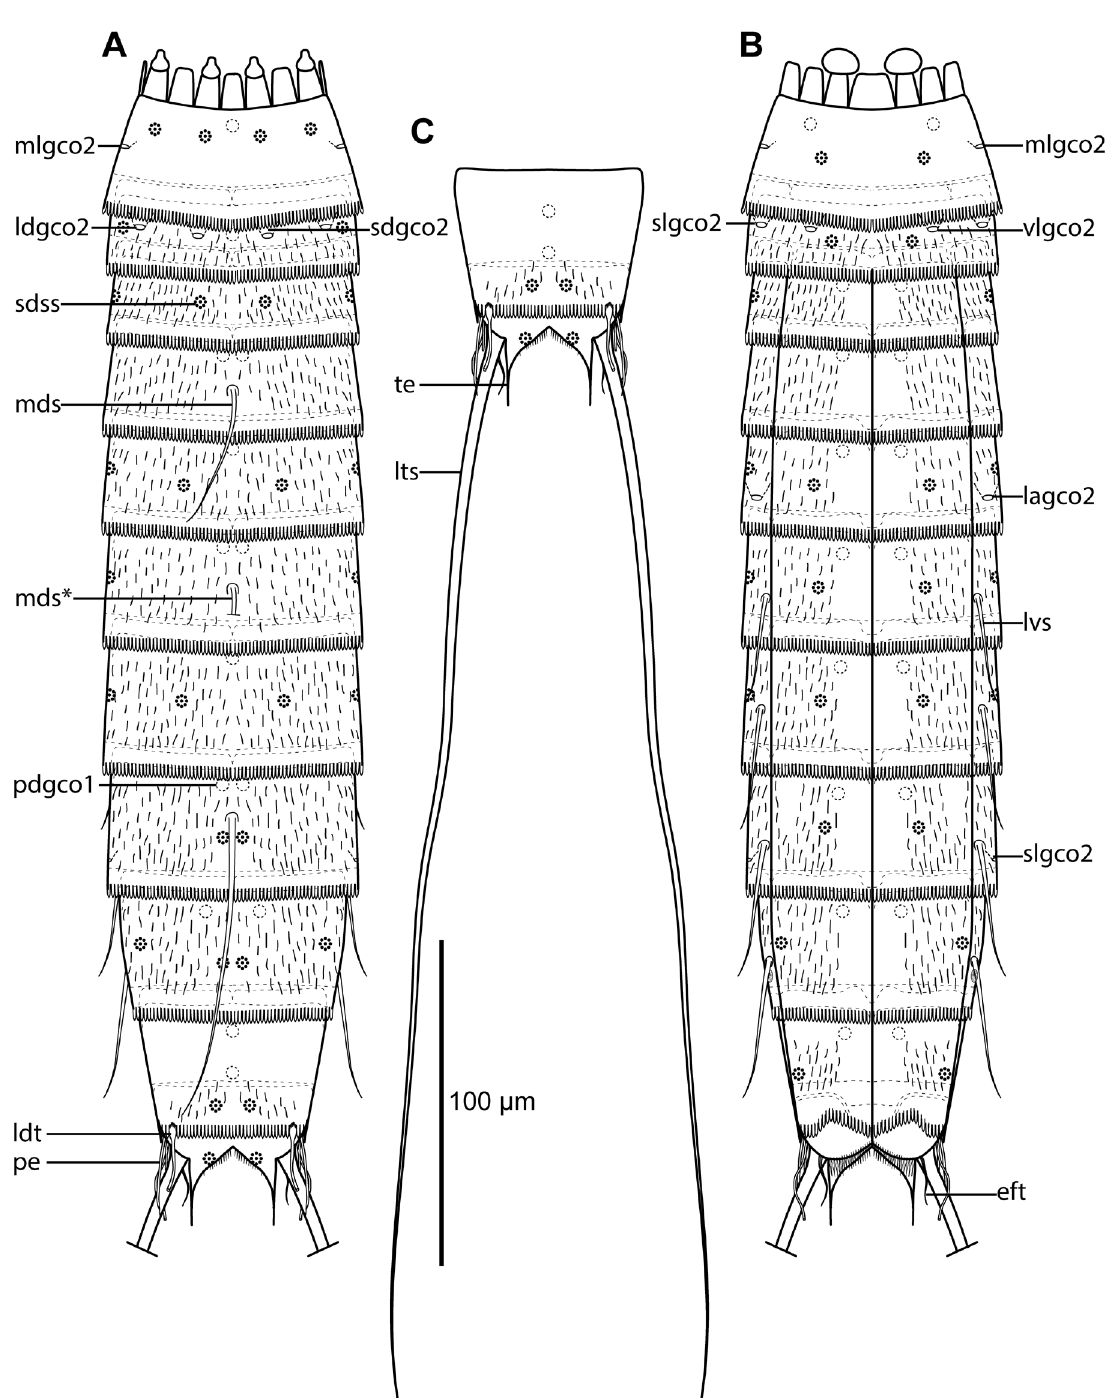
Fig. 2. Line art illustrations of Echinoderes anniae sp. nov. A . ♂, dorsal view. B . ♂, ventral view. C . Segments 10 to 11 in male, with lateral terminal spines drawn in full length, dorsal view. Abbreviations: eft = extended fringe tips; lagco2 = lateral accessory glandular cell outlet type 2; ldgco2 = laterodorsal glandular cell outlet type 2; ldt = laterodorsal tube; lts = lateral terminal spine; lvs = lateroventral spine; mds = middorsal spine (*broken); mlgco2 = midlateral glandular cell outlet type 2; pdgco1 = paradorsal glandular cell outlet type 1; pe = penile spines; sdgco2 = subdorsal glandular cell outlet type 2; sdss = subdorsal sensory spot; slgco2 = sublateral glandular cell outlet type 2; te = tergal extensions; vlgco2 = ventrolateral glandular cell outlet